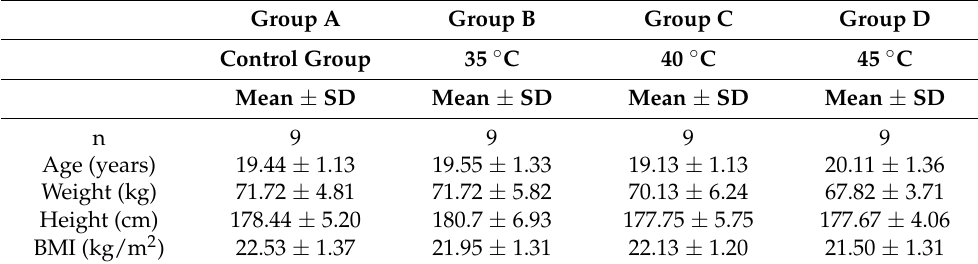
Table 1. General characteristics and grouping of participants. Group A Group B Group